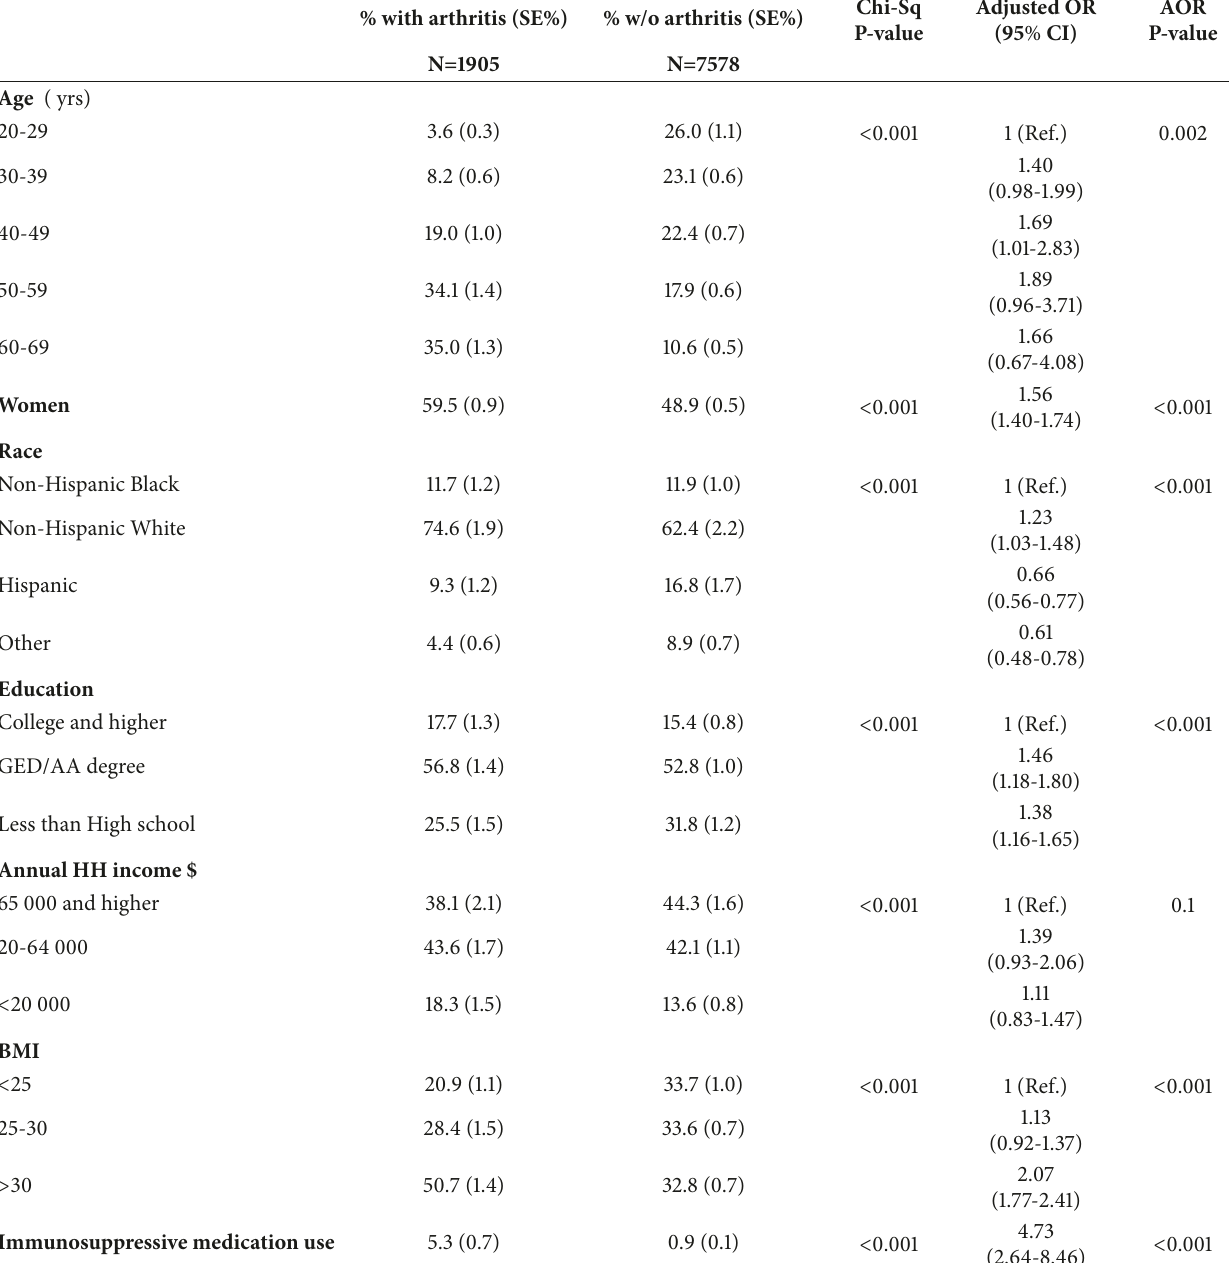
Table 1: Demographic characteristics of US adults, ages 20-69, with and without arthritis (N =